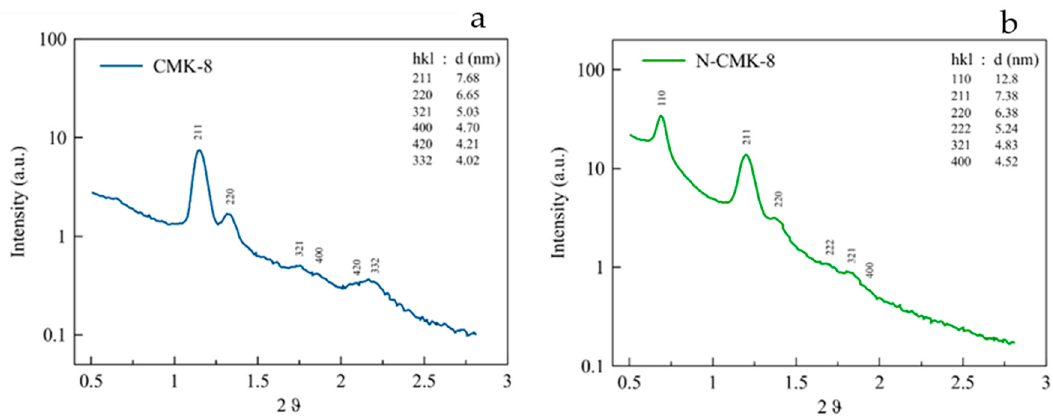
Figure 2. Small angle X-ray scattering (SAXS) patterns for CMK-8 and N-CMK-8. ( a ) SAXS pattern of CMK-8, ( b ) SAXS pattern of N-CMK-8. In both a and b panels, the peaks are indexed as